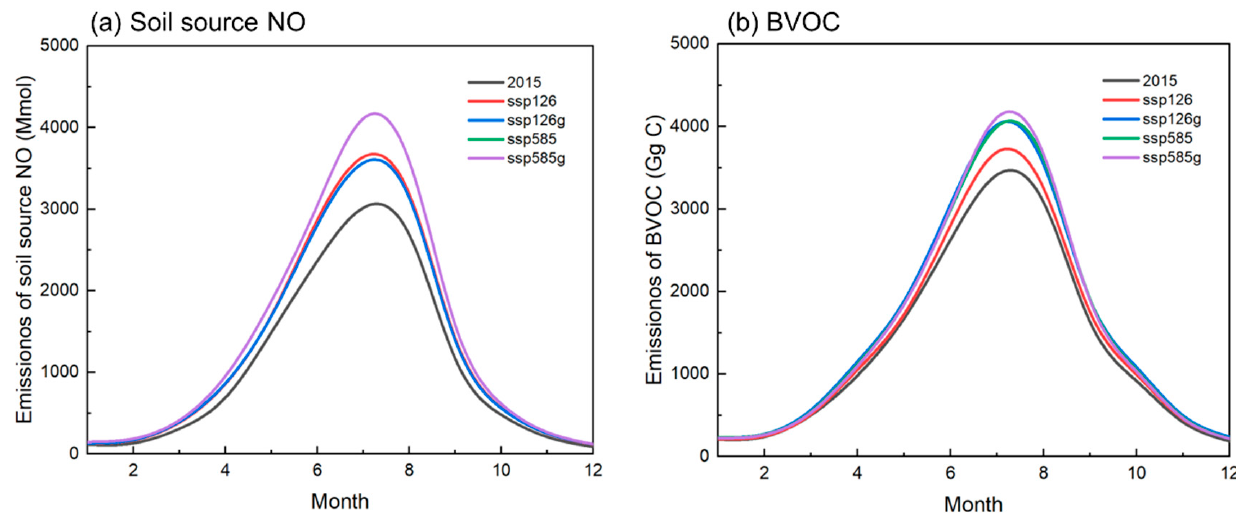
Figure 4. Monthly variations in ( a ) soil-source NO and ( b ) BVOC emissions under various SSP scenarios.